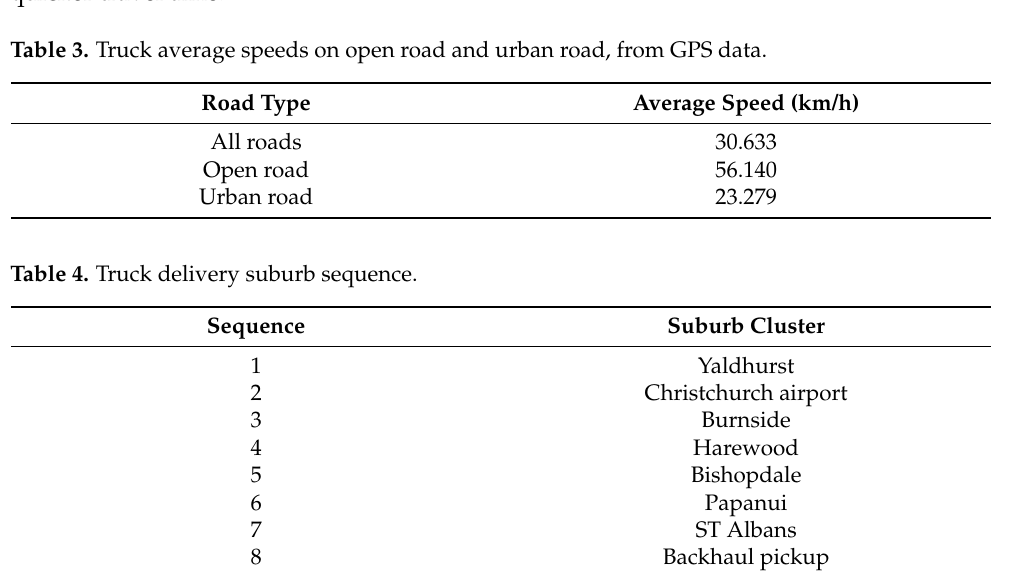
Figure 5. Transport network of simple suburb cluster model.